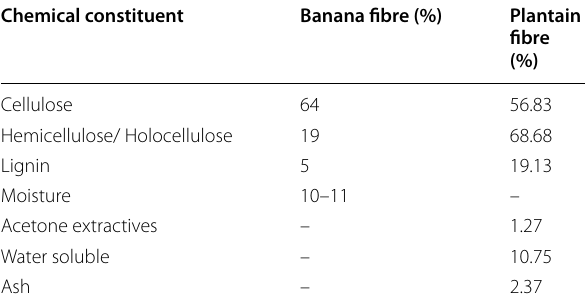
Table 3 Chemical composition of extracted Musa spp.